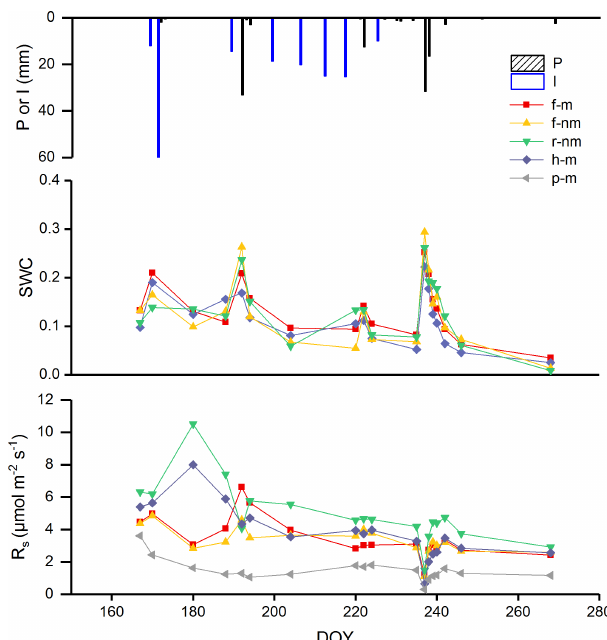
Figure 8. Response of soil moisture and soil respiration to pre- cipitation and irrigation during 2016 (f-m, h-m and p-m represent the furrow, planting hole, and plastic mulch in the mulched field, respectively; f-nm and r-nm represent the furrow and ridge in the non-mulched field, respectively).